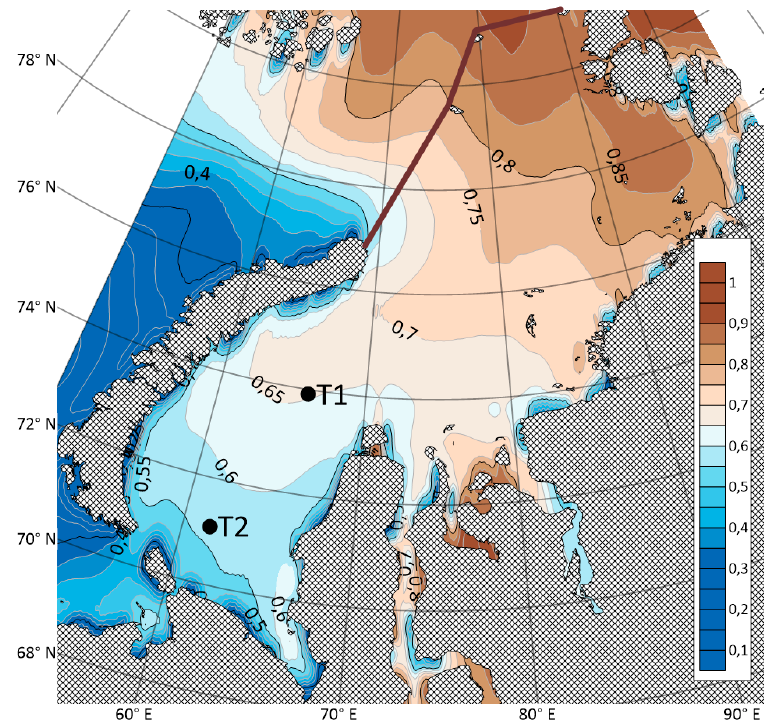
Figure 6. The long-term average probability of the ice presence of with a concentration more than 50% in the Kara Sea according to reanalysis data from 1979 to 2017 (in 0–1 unit). T1 and T2 are a points where the ice probability and wind events analyses provided.